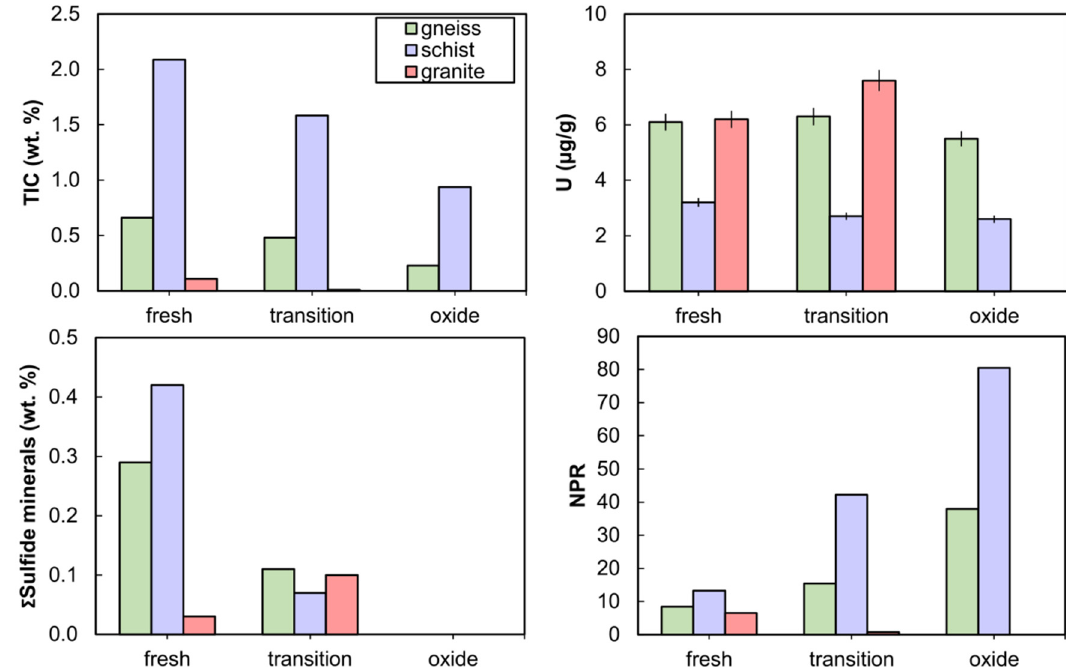
Figure 4. Solid-phase composition of rocks used in kinetic tests: total inorganic carbon (TIC), uranium, sum of sulfide minerals (from quantitative evaluation of materials by scanning electron microscopy, QEMSCAN), and neutralization potential ratio (NPR) as a function of rock type and weathering facies. Error bars on U abundance are ±5%.